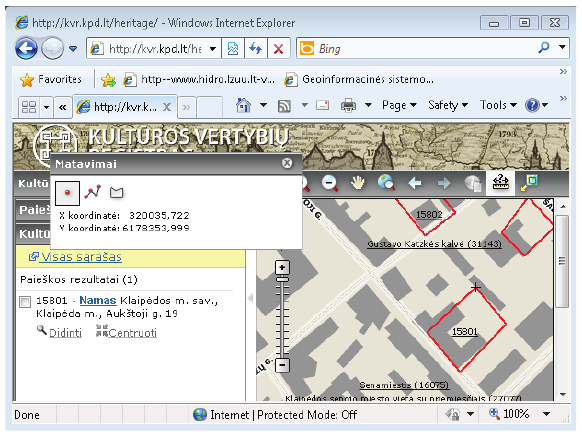
Fig. 2. Data from register of the cultural